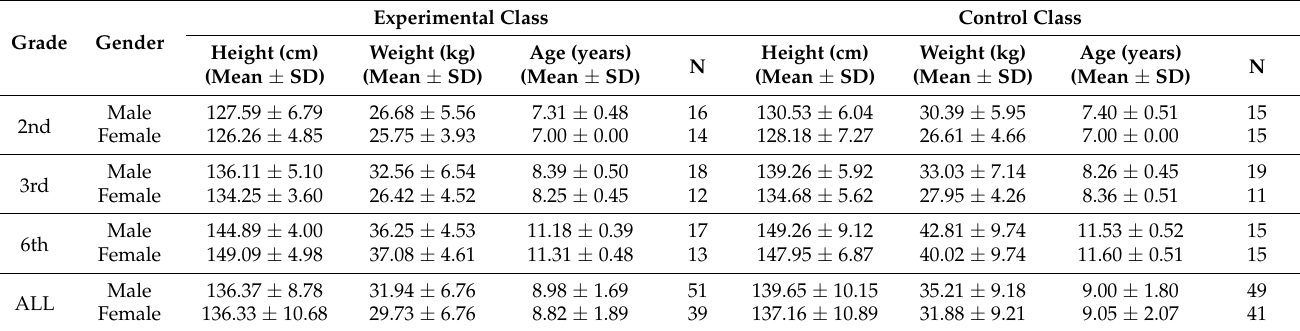
Table 2. Descriptive statistics for participants’ anthropometric